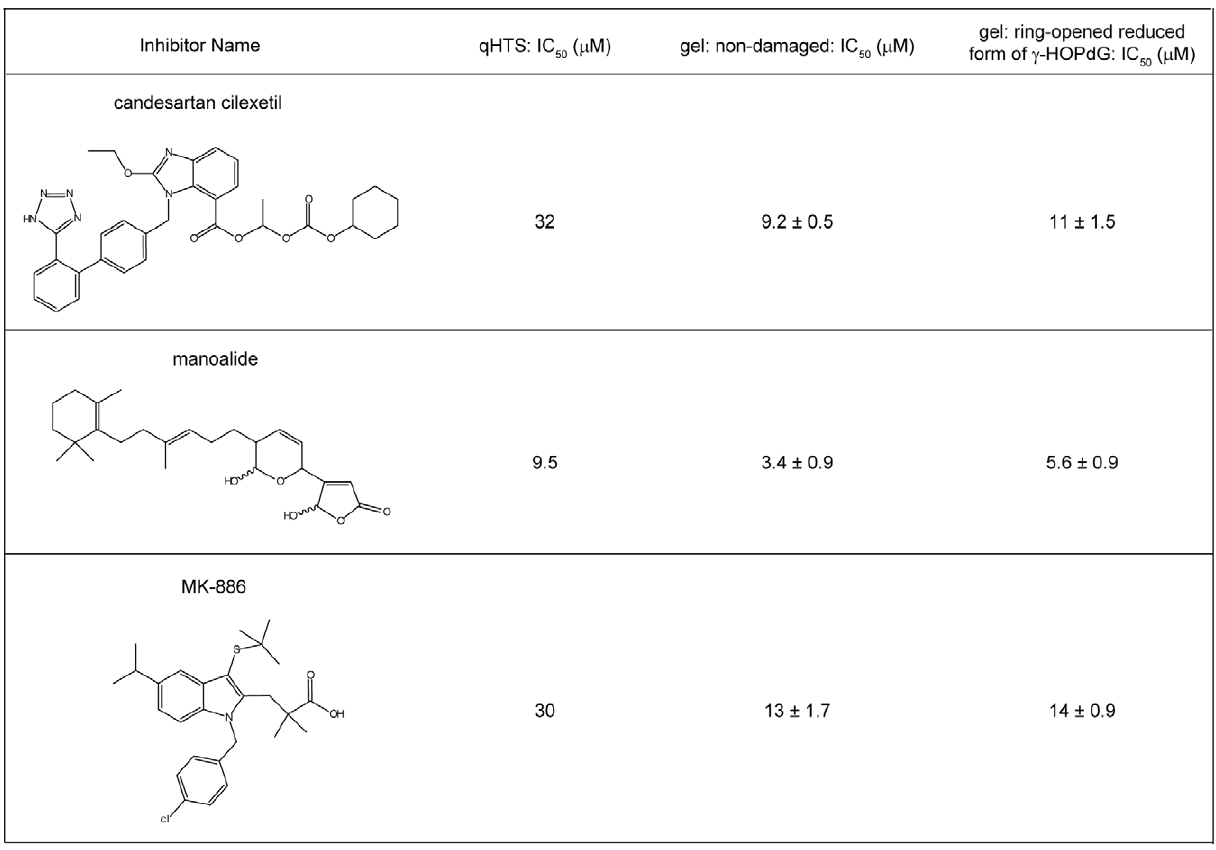
Figure 4.Summary of IC 50 s of candesartan cilexetil, manoalide, and MK-886 from qHTS and primer extension assays. In primer extension assays, three independent experiments were carried out, and IC 50 s are shown as average 6 standard error.